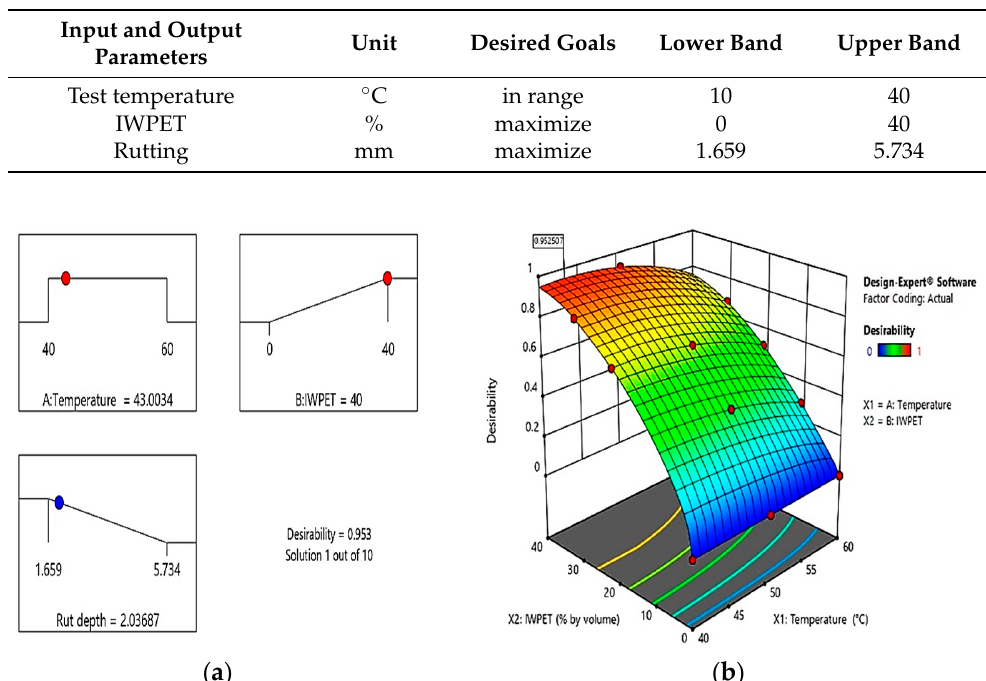
Table 8. Optimization thresholds for rutting response.